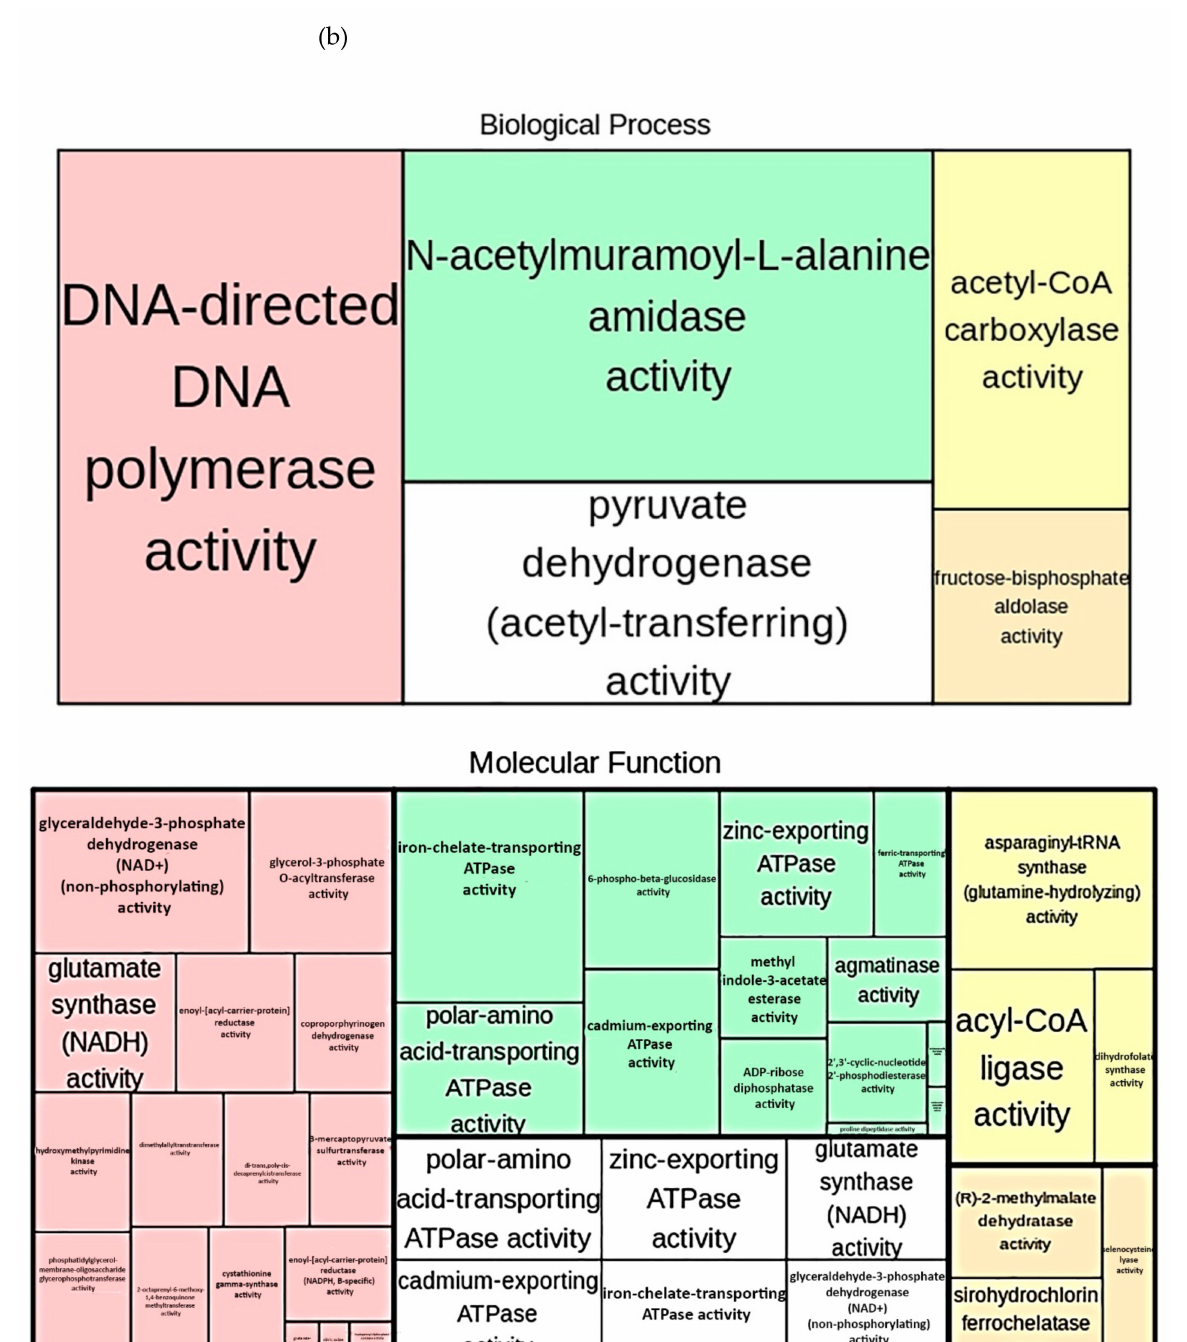
Figure 5. Tree map of biological processes and molecular functions as predicted using the PICRUSt2 software and analyzed against the KEGG database: ( a ) molecular functions and the biological processes in which they were retrieved, showing a frequency of Db > 1%, and ( b ) molecular functions and the biological processes in which they were retrieved, showing a frequency of Db <